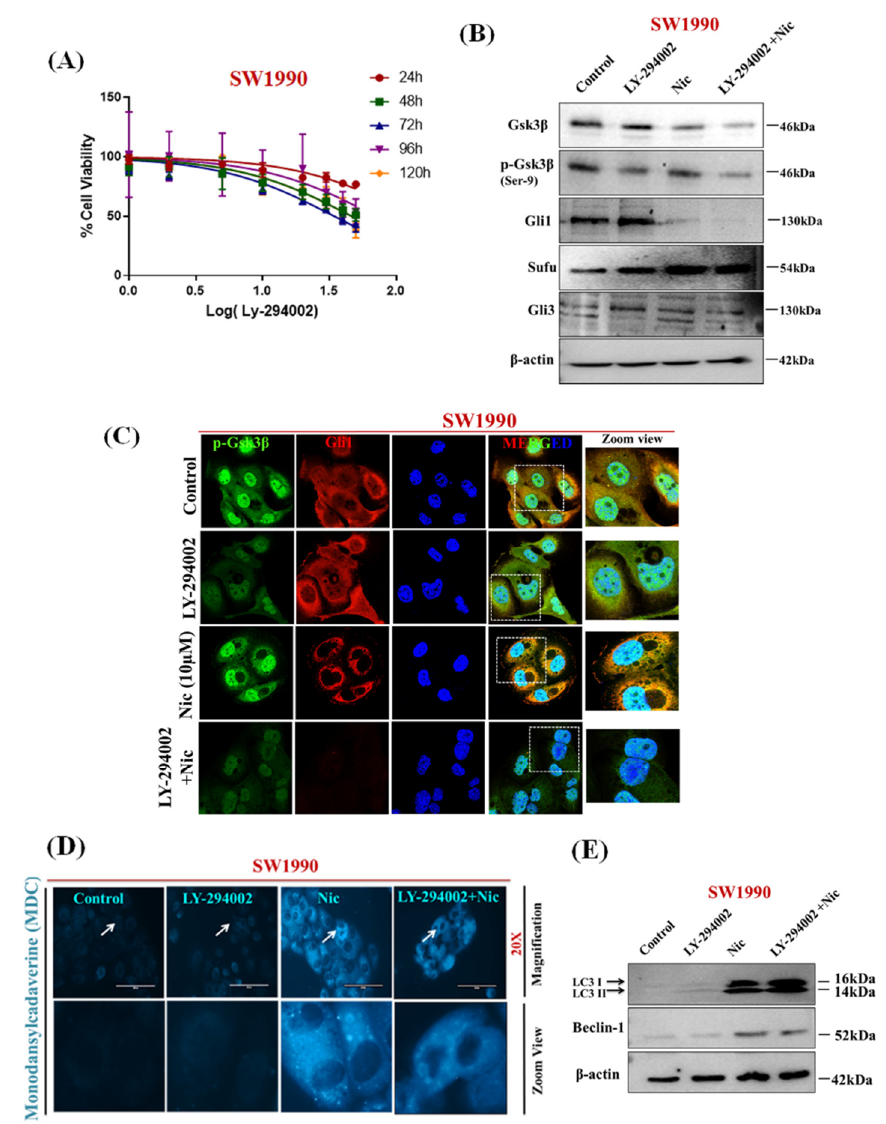
Figure 7. Nic induced Gsk3 β inactivation inhibits Gli1 activation, negatively impacting Hh signal- ing and promoting autophagy-mediated apoptosis ( A ) Cell viability curve for LY-294002 (Gsk3 β - activator) on SW1990 following 24, 48, 72, 96, and 120 h exposure followed by MTT assay. Values are expressed as mean ± SEM ( n = 5). ( B ) Representative Western blot images showing the expression of p-Gsk3 β , Gsk3 β , Gli1, Sufu, and Gli3 in SW1990 cells treated with vehicle or LY-294002 (30 µ M) or Nic (30 µ M) alone or in combination with LY-294002 for 24 h. ( C ) Representative CLSM